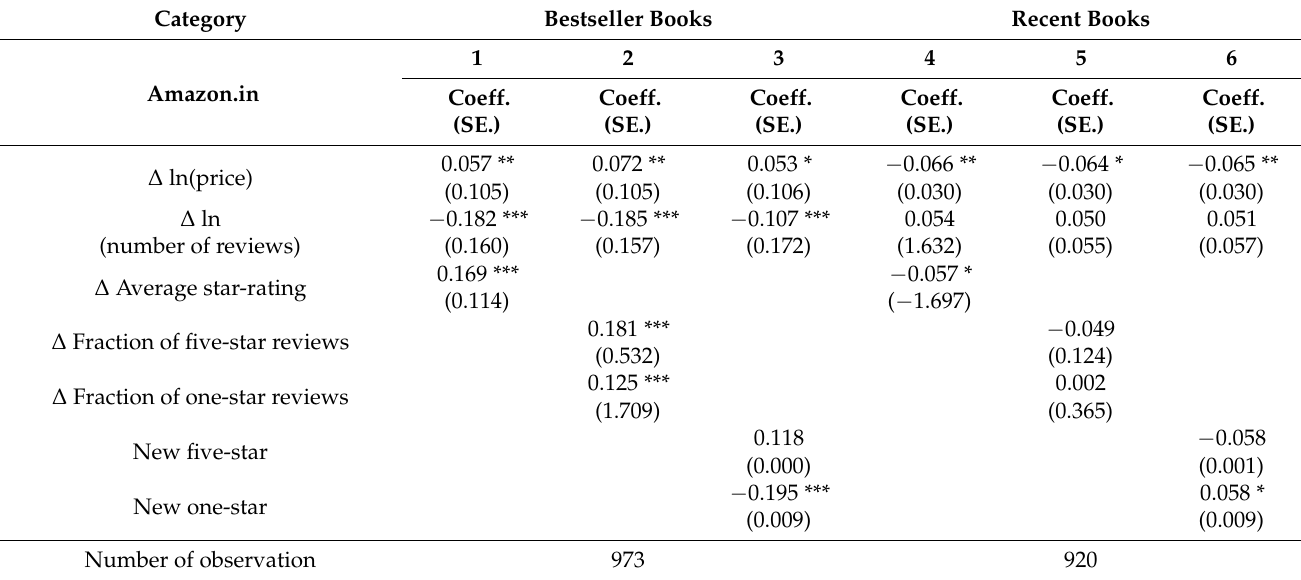
Table 5. Effect of four-month change in reviews on sales